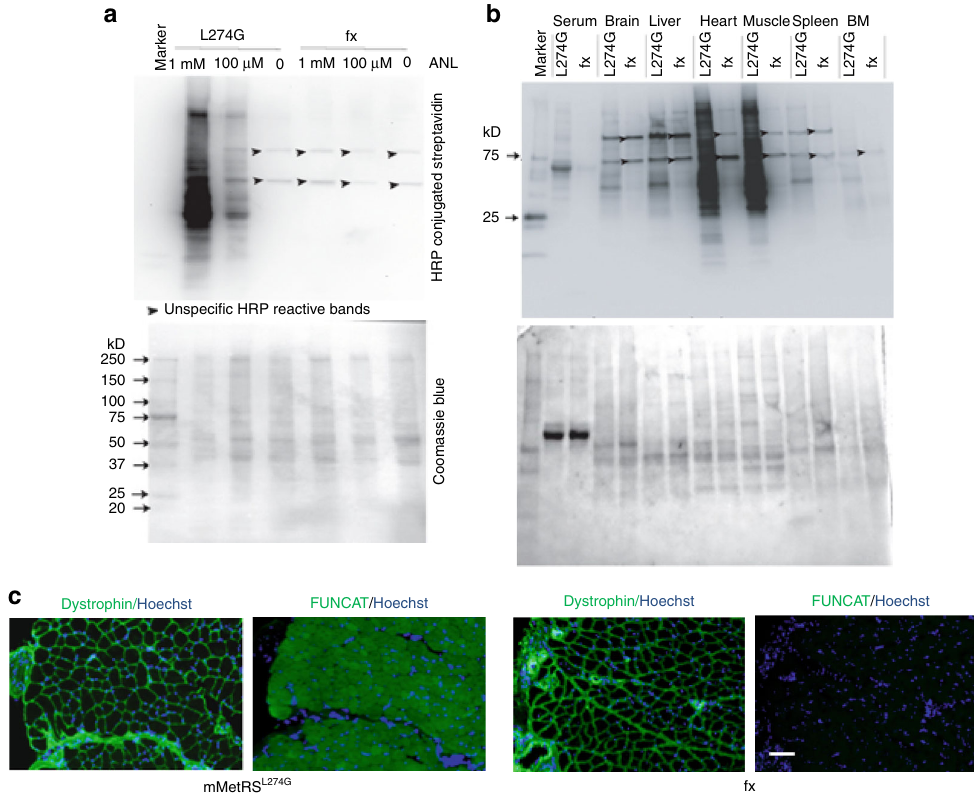
Fig. 2 Bio-orthogonal metabolic labeling in mammalian cells in vitro and in mice in vivo. a Click-western blotting was performed as described in Methods. The in vitro BONCAT of MetRS L274G fi broblasts has resolved an ANL dose-dependent protein tagging (smears), as compared to the low background of fx cells. The nonspeci fi c bands ( arrowheads ) were present even without ANL treatment in MetRS L274G samples and in fx samples. Coomassie blue image shows similar protein loading for each lane. Similar results were obtained with cells derived from three animals of each strain. b In vivo Click-western blotting, which was performed as detailed in Methods, has resolved the incorporation of ANL into all examined tissues of MetRS L274G mice (smears of proteins), as compared to the background signal of fx tissues. The same non-speci fi c bands as described above were present in all samples (arrowheads). Coomassie blue staining is shown as loading control. Three independent experiments with each mouse strain, yielded similar results. c 10-micrometre TA muscle cryosections were prepared and assayed by FUNCAT; and the adjacent sections (~ 10 micrometre away) were stained with dystrophin antibody. Robust FUNCAT signal was detected in MetRS L274G dystrophin positive muscle, as compared with the low background fl uorescence of fx muscle. Scale bar , 100 μ m. Three independent experiments with each mouse strain, yielded similar